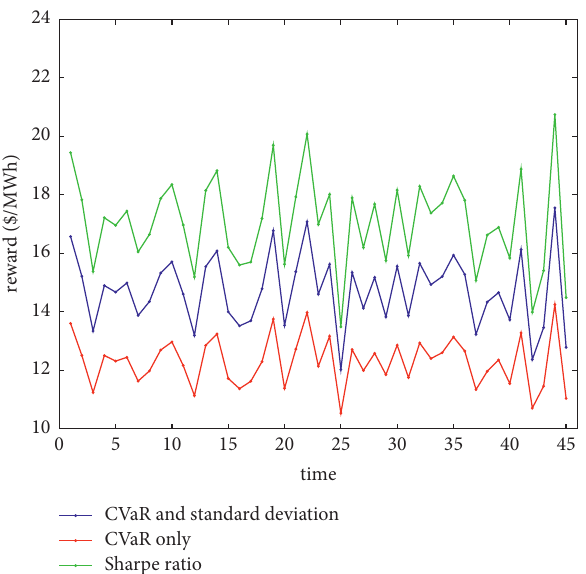
Figure 2: Rewards of future 45 transactions on two markets.